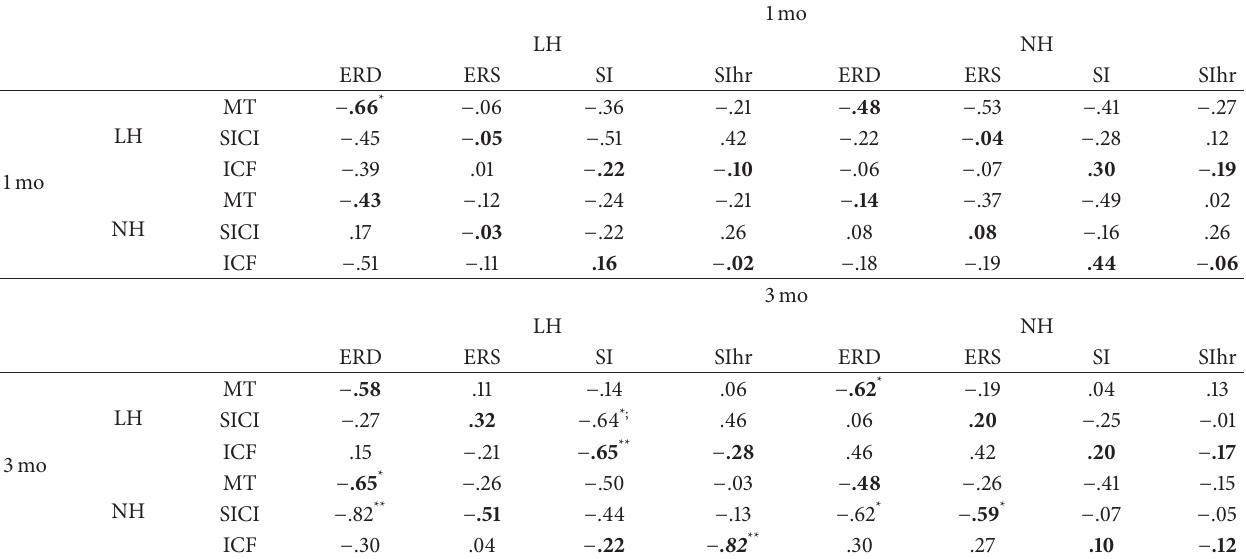
Table 2: Spearman correlations between the nTMS and MEG parameters at 1 month (1mo) and three months (3 mo) after the stroke. The correlations between event-related desynchronization (ERD) and motor threshold (MT), event-related synchronization (ERS) and short- interval cortical inhibition (SICI), and intracortical facilitation (ICF) and somatosensory evoked field source strength (SI) and somatosensory hand representation area (SIhr), aligned with hypotheses, are depicted in bold font. * Significance of 𝑝 < .05 ; ** significance of 𝑝 < .01 without multiple comparison correction; ** (marked with bold italic) statistical significance ( 𝑝 < .05 ) with multiple comparison correction (Bonferroni) for 𝑁 = 32